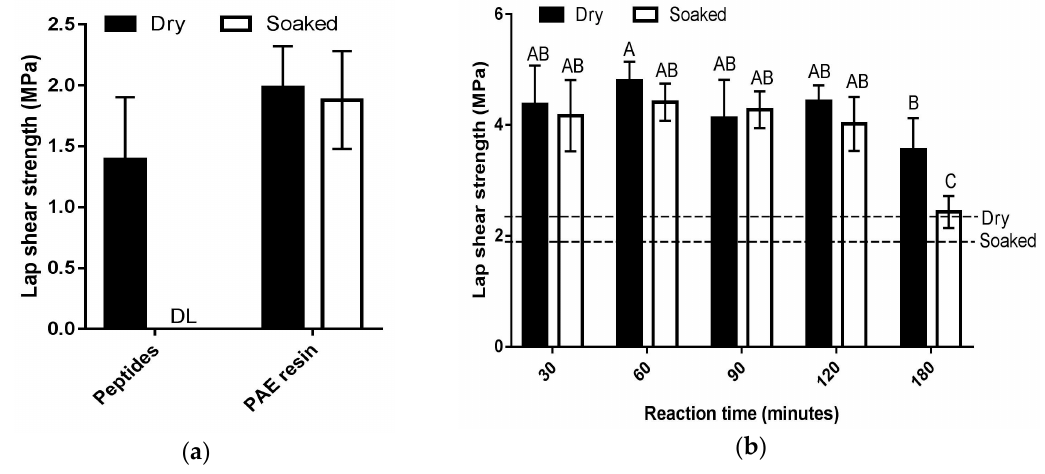
Figure 2. Lap shear strength of plywood specimens bonded with peptides or PAE resin alone ( a ); or peptides–PAE adhesives crosslinked for various amounts of time ( b ). For peptides–PAE formulations, 1.88 g of peptides were mixed with 20.0 g PAE resin (peptides: PAE resin = 1:1.33 on dry weight basis). Specimens were hot pressed at 120 °C and 3.5 Mpa for five min. Error bars indicate standard deviation of six plywood specimen measurements. Some specimens delaminated when soaked in water (DL). Means that do not share a letter are significantly different (Tukey, 95% confidence level). The minimum shear strength requirements as specified by ASTM D4690 are shown: 2.344 MPa for dry shear strength; and 1.93 MPa for soaked shear strength [34].